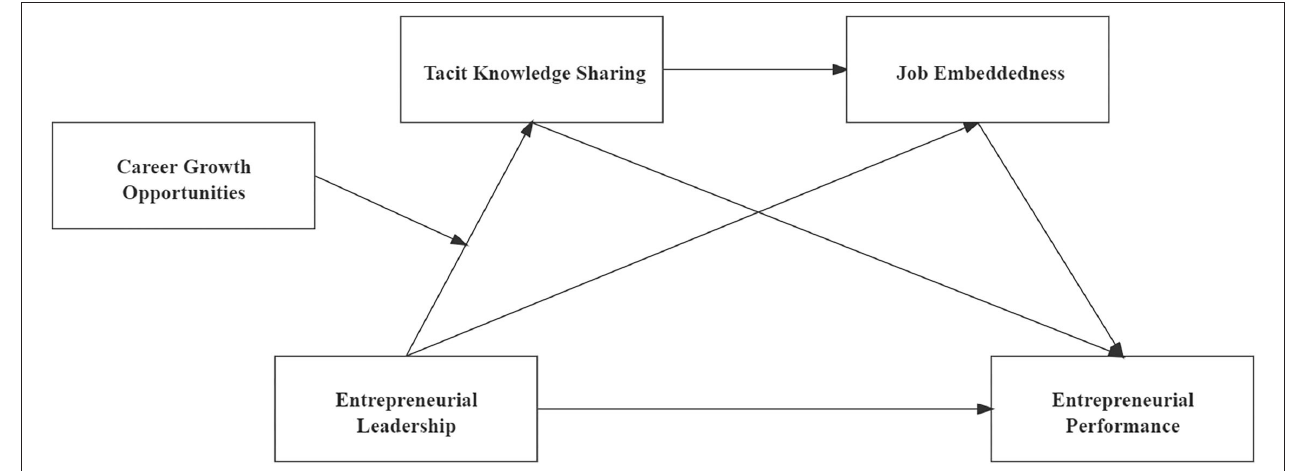
FIGURE 1 | Conceptual